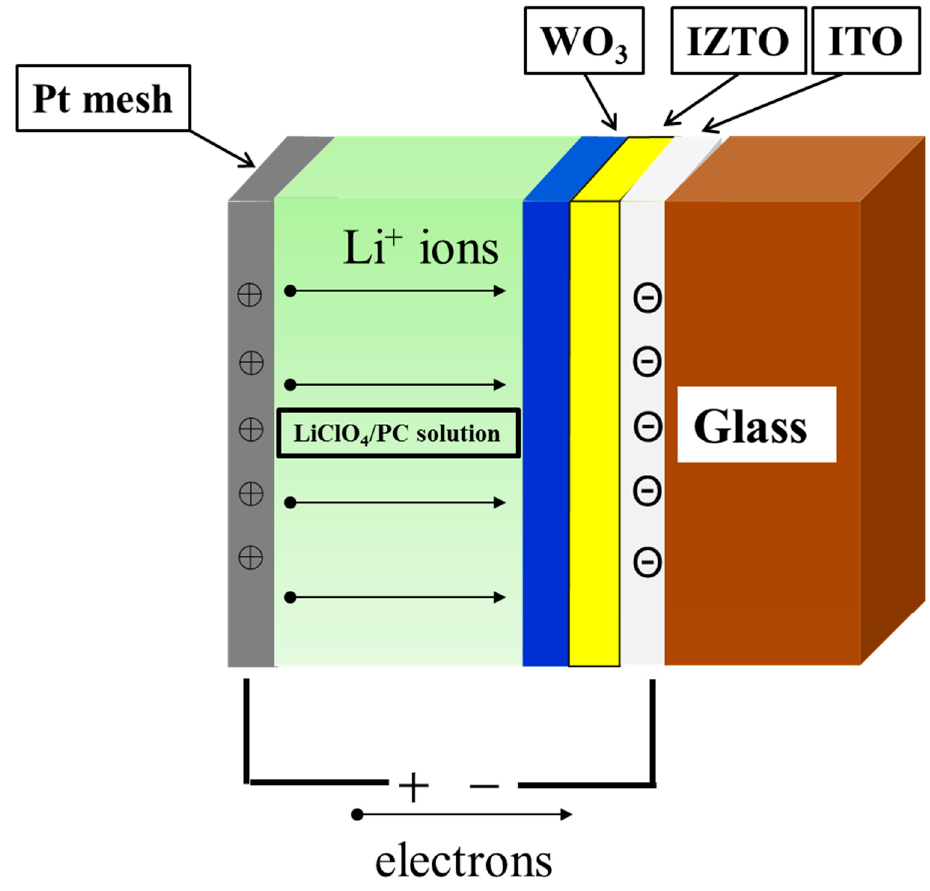
Figure 1. The typical ECD structure.